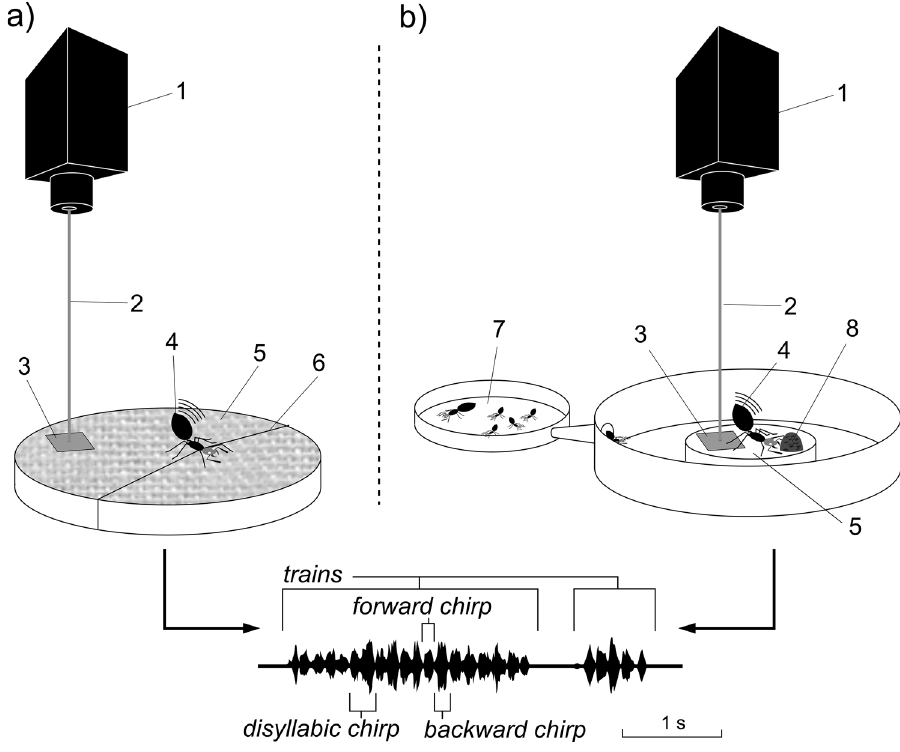
Figure 1. Recording set up of the restraining ( a ) and food choice ( b ) trials; 1–2 laser vibrometer, 3 reflective tape, 4 stridulating ant, 5 sheet of paper, 6 cotton thread, 7 nest arena connected to the foraging one, 8 honey drop. Below an example of an ant stridulatory